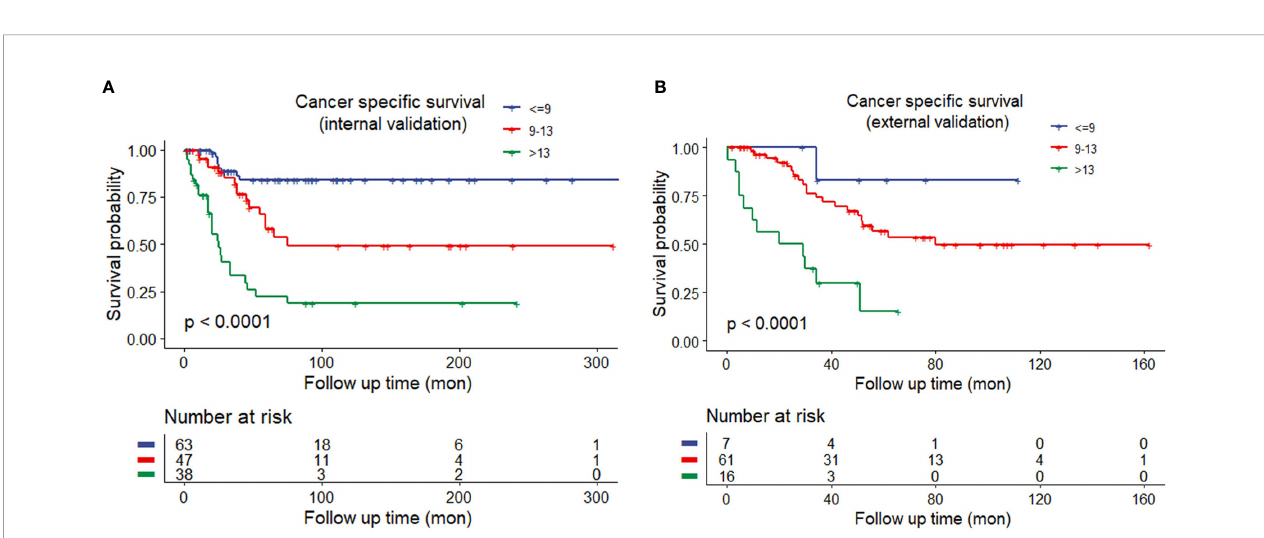
FIGURE 3 | (A) C-index of three nomograms in the internal validation cohort. (B) Calibration plot of three nomograms in the internal validation cohort. (C) C-index of three nomograms in the external validation cohort. (D) Calibration plot of three nomograms in the external validation cohort.